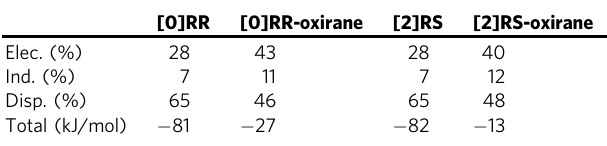
Table 3 Predicted SAPT energy decomposition for the interaction of oxirane